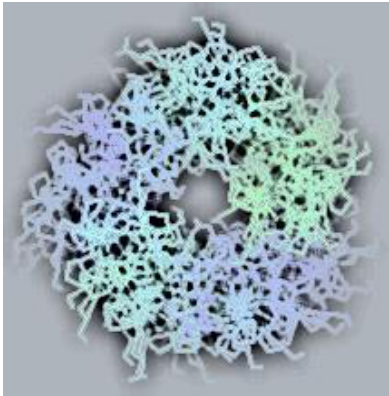
Figure 3. Coils and nets in the gelatin structure.